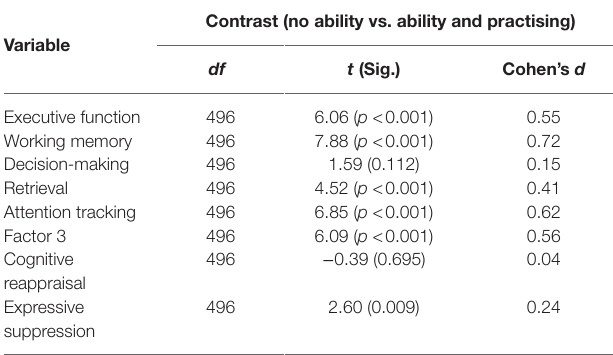
TABLE 3 | Analysis of variance (ANOVA) and pairwise comparison summary for TABLE 4 | Contrasts between no ability, ability and practising groups in relation outcome variables. to executive functioning. ANOVA Pairwise comparison Variable Ability overall No ability No ability vs. Ability vs. vs. Ability Practising Practising Variable Mean diff. Mean diff. Fdf (Sig.) Mean diff. (Sig.) (Sig.) (Sig.)